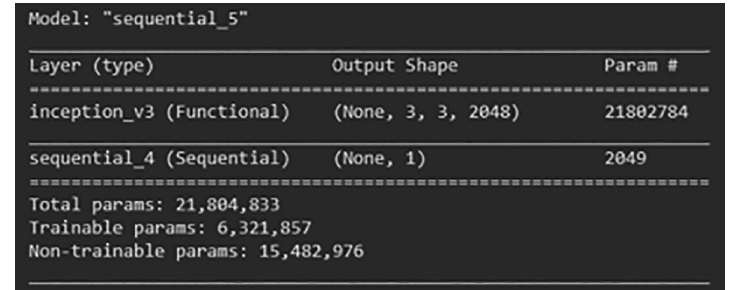
Figure 11. Architecture of fine-tuned